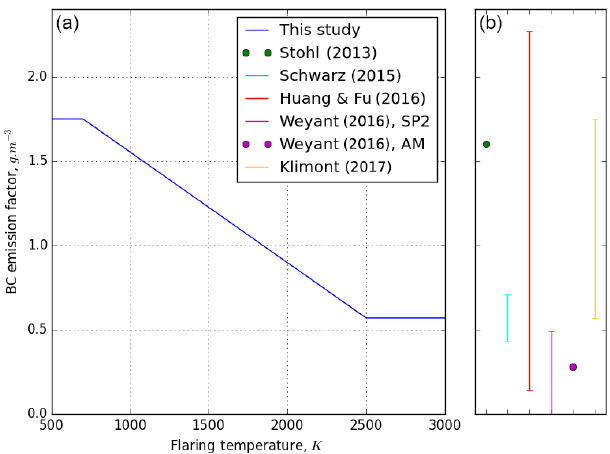
Figure 3. (a) BC emission factor function used in the present study. The emission factor is bounded by the extremes of the range used in the GAINS model (0.5–1.75gm − 3 ) (Klimont et al., 2017) and scaled as a function of the flaring temperature, used as an indica- tion of combustion completeness. (b) For comparison purposes, the EFs derived by Stohl et al. (2013), Schwarz et al. (2015), Huang and Fu (2016), Weyant et al. (2016) (using the Single Particle Soot Photometer, SP2, or the Particle Soot Absorption Photometer, AM), and Klimont et al.